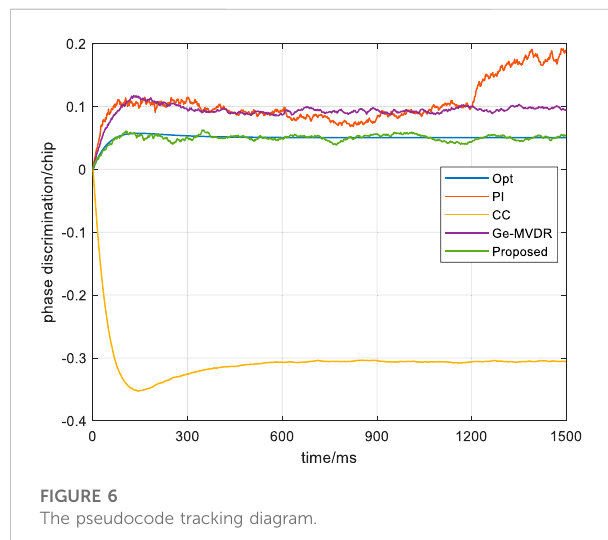
FIGURE 6 The pseudocode tracking diagram.